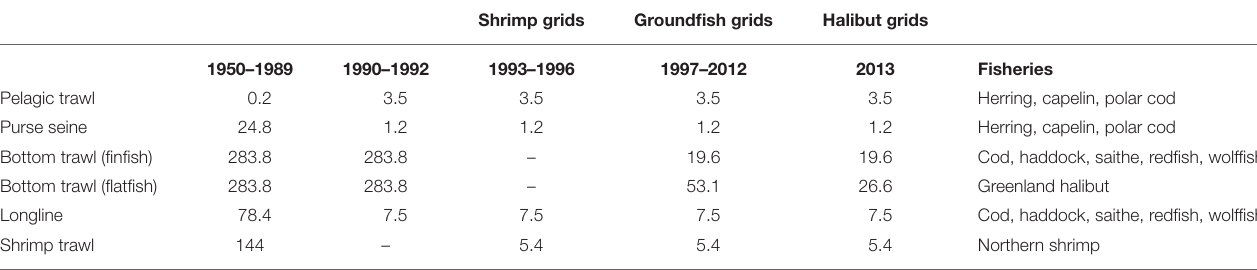
TABLE 4 | Discard rates as a percentage of retained catch (landings) by major gear types over time for the Russian Barents Sea